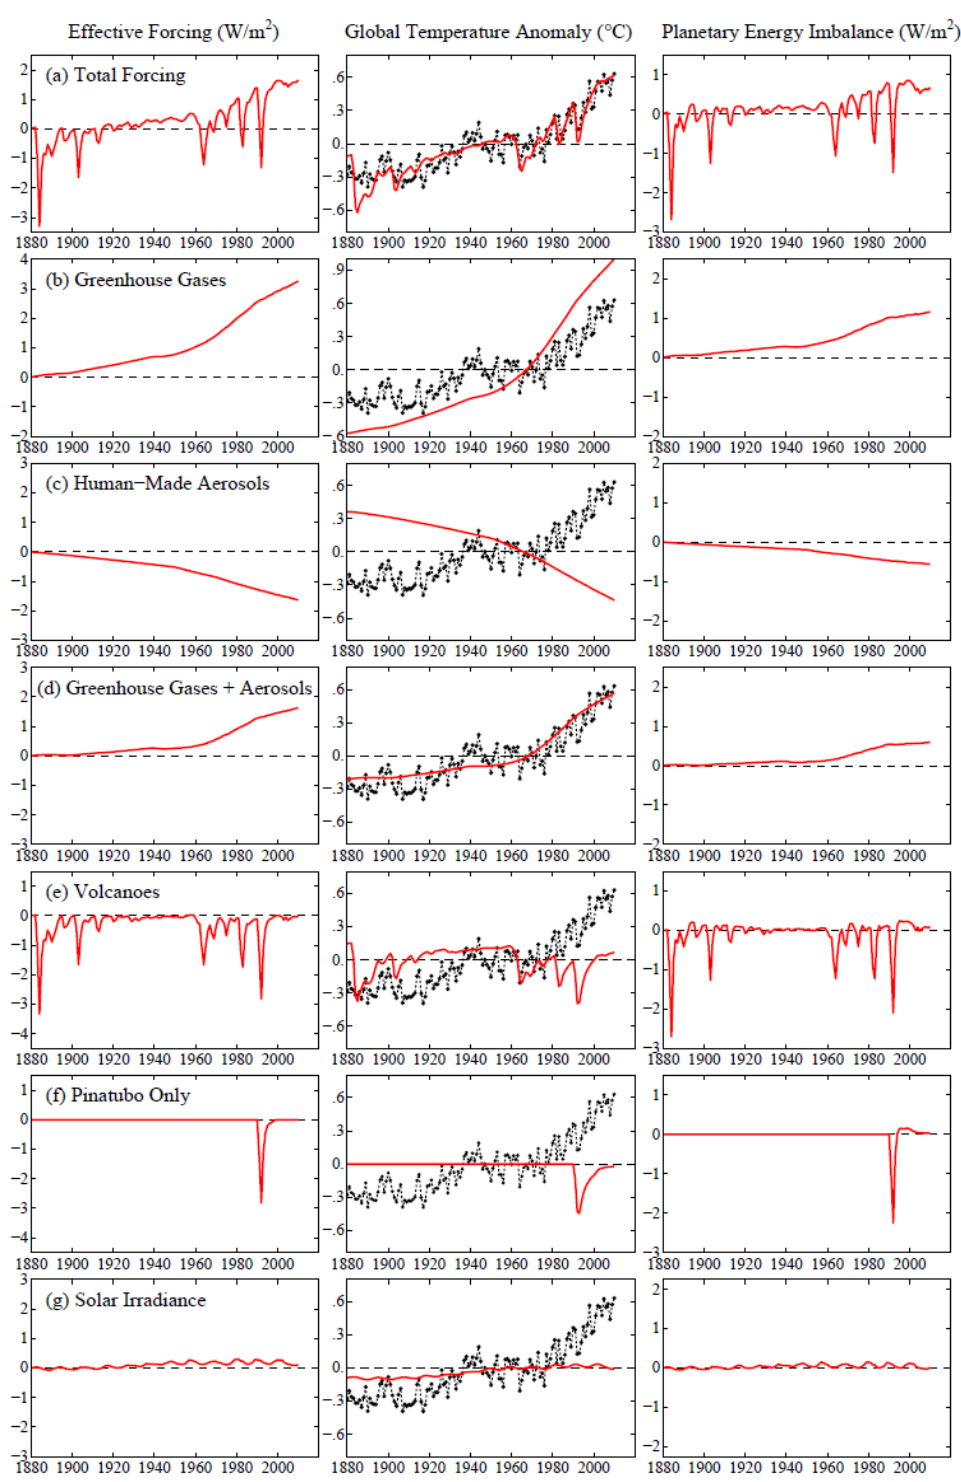
Fig. 18. Climate forcings and their contributions (red curves) to temperature change and planetary energy imbalance. (a) shows the effect of the total forcing and (b) through (g) show effects of individual forcings. Observed global temperature change is included in the middle column for comparison; base period for temperature is 1951–1980 (zero mean) for observations and model.